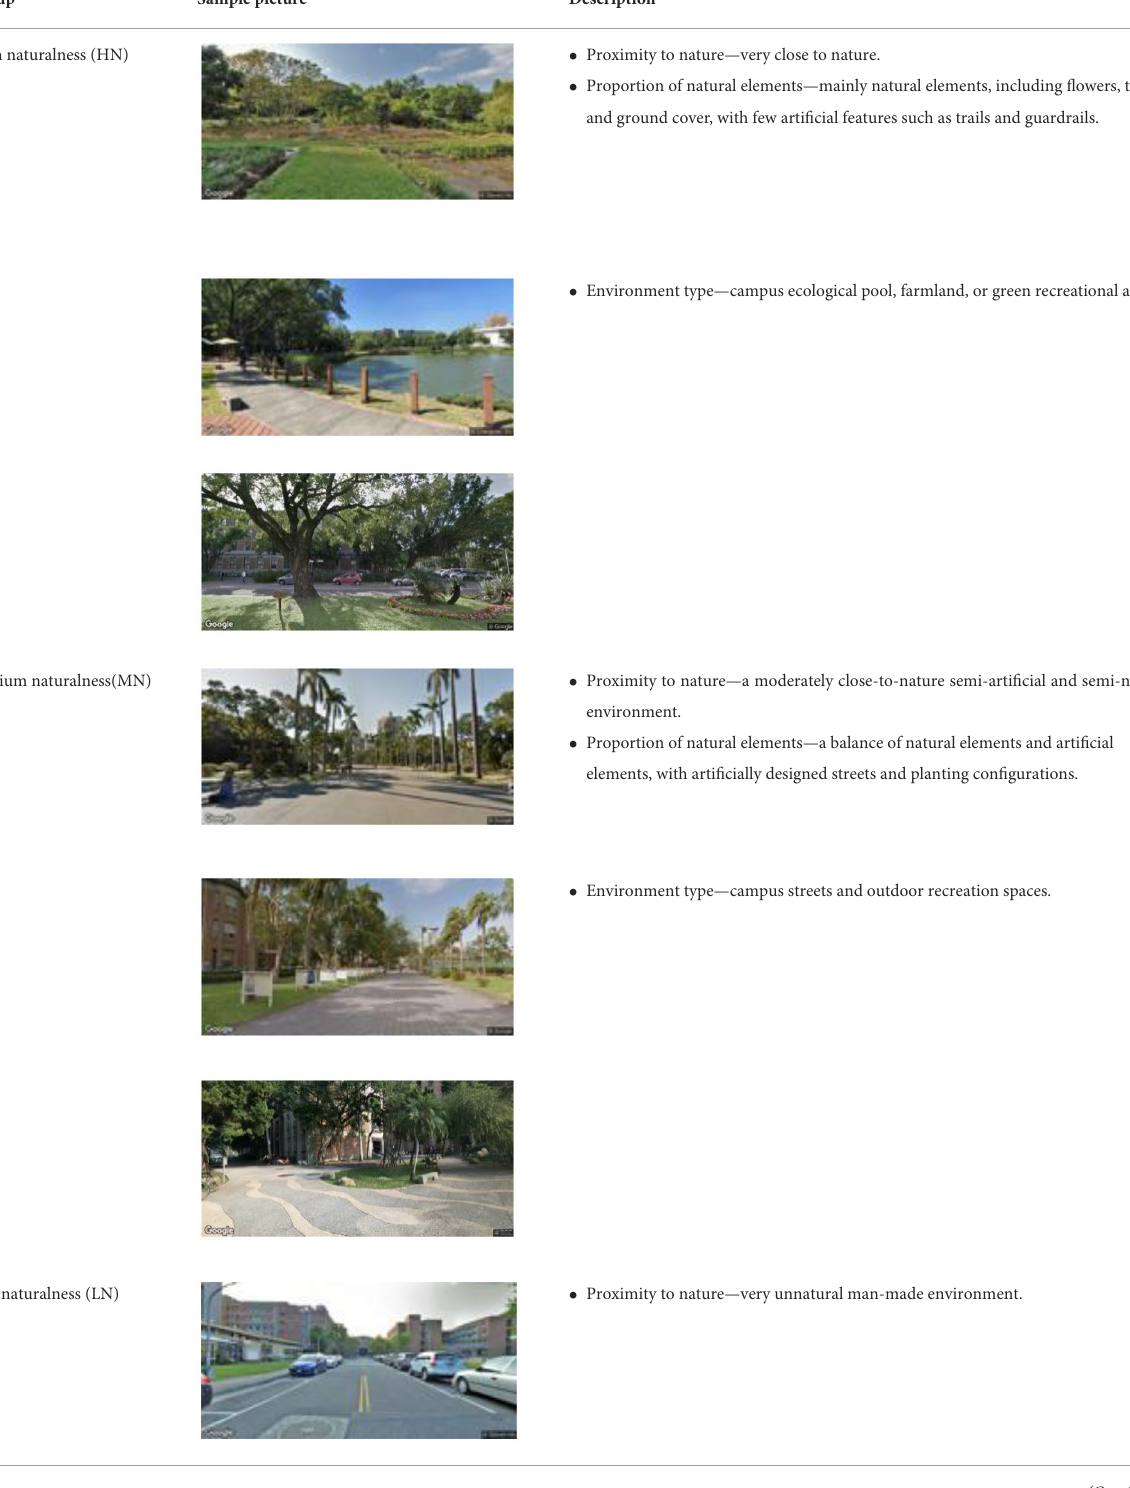
TABLE 1 Definitions of environmental photo content for each degree of perceived